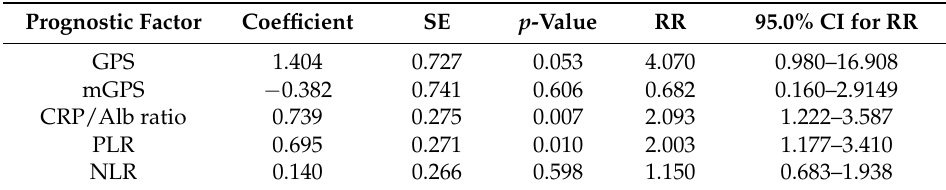
Table 2. Multivariate Cox regression analyses of the inflammation-based prognostic scores of nasopharyngeal carcinoma (NPC) patients.